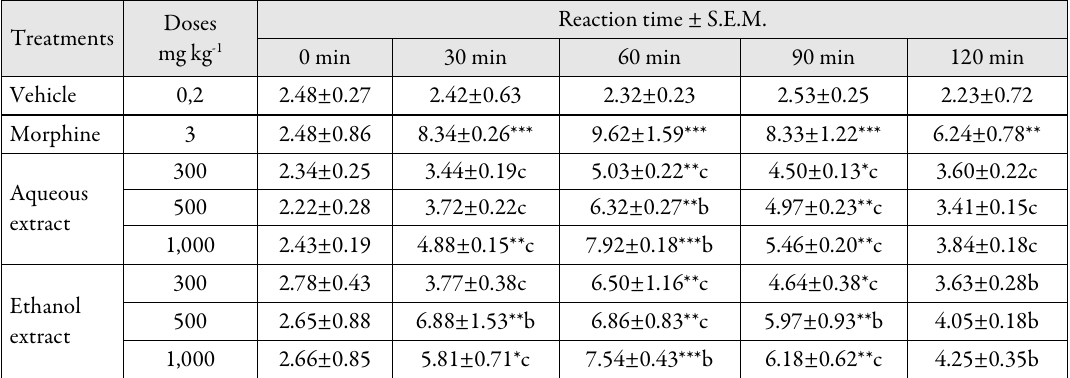
Table 3. Analgesic effect of aqueous and ethanol extracts of O. ficus-indica flowers on latency via the hot